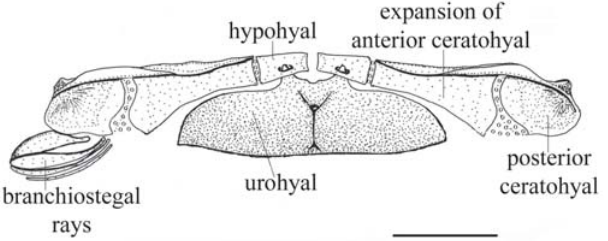
Fig. 21. Anterior view of hyoid and branchial arches of Lamontichthys stibaros (FMNH 84111, 62.4 mm SL). Branchial filaments not represented. Scale bar = 2